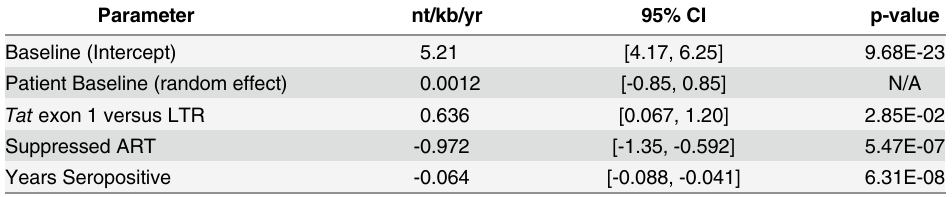
Table 2. The calculated effect sizes of fixed effects for the patients shown in Fig